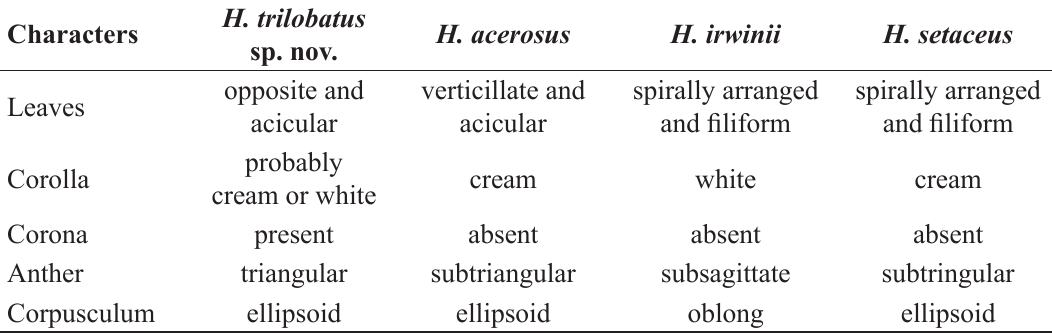
Table 1. Diagnostic characters to distinguish the species of Hemipogon s.